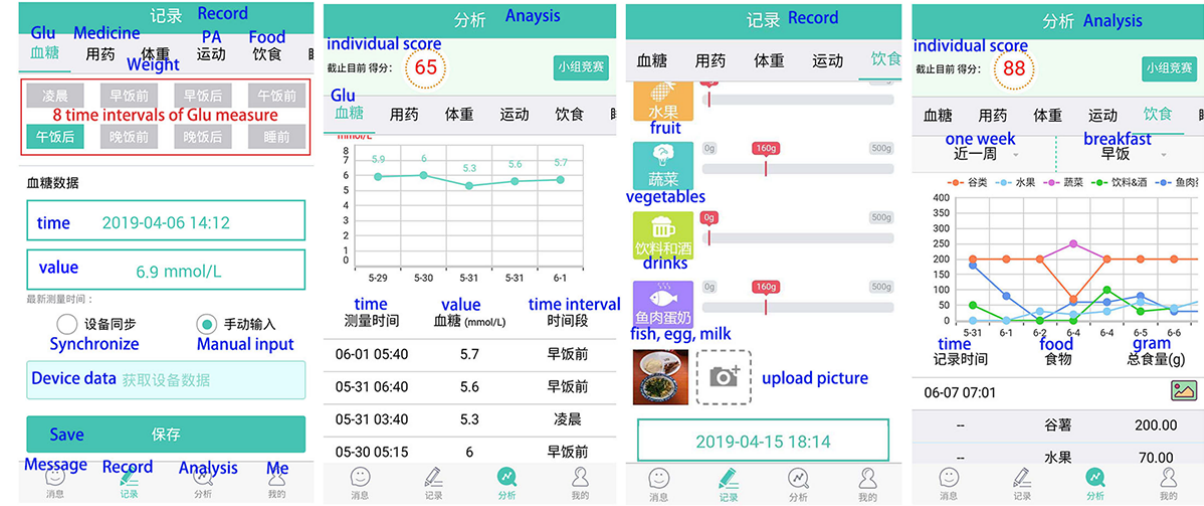
Figure 2. Screen capture images from the DiaSocial